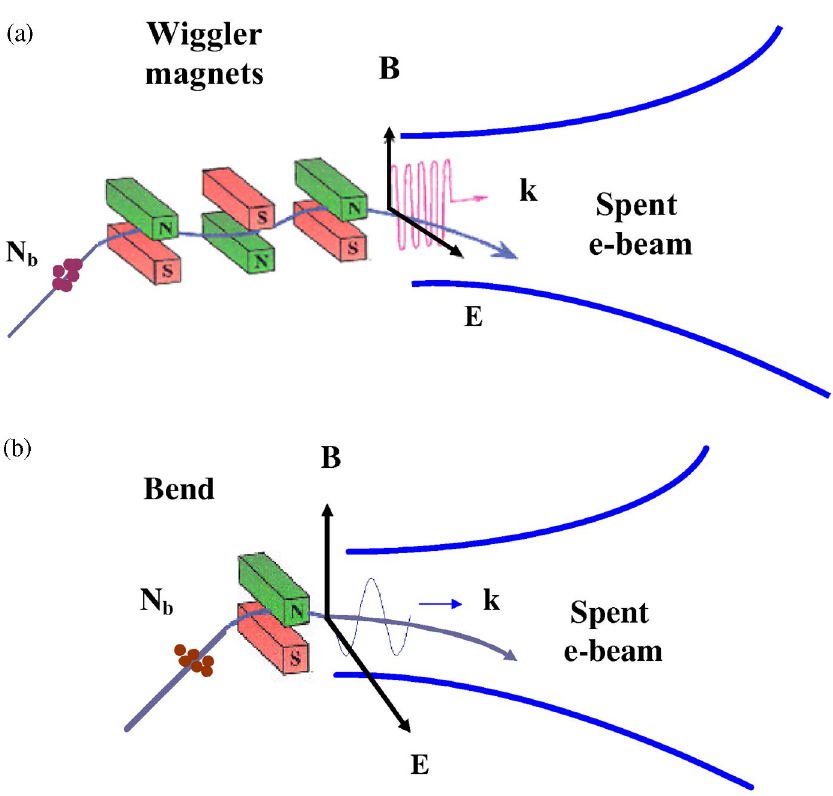
FIG. 1. (Color) Prebunched e -beam radiation schemes: (a) prebunched free electron maser (FEM)/FEL (or synchrotron-undulator radiation) and (b) coherent synchrotron